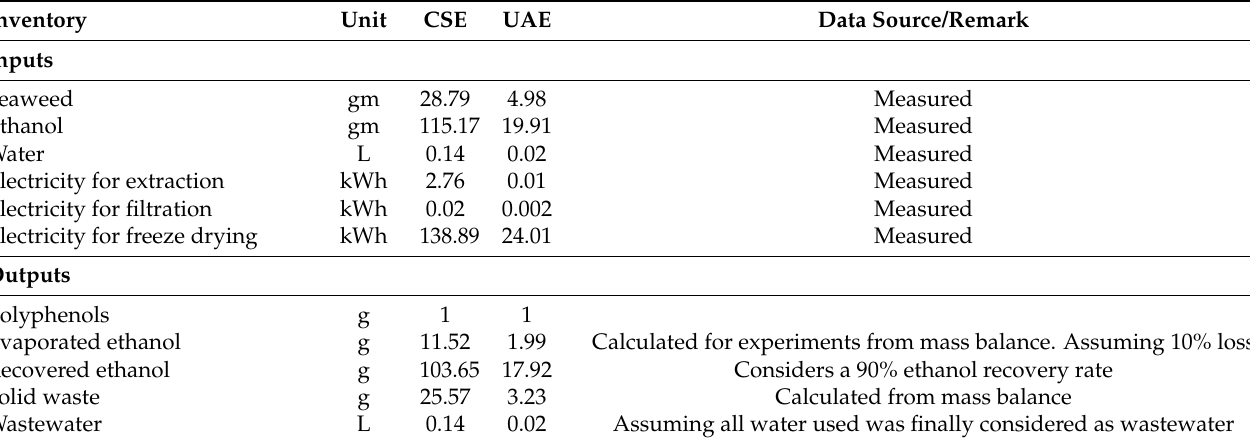
Table 1. Life cycle inventory data for extraction processes (per g